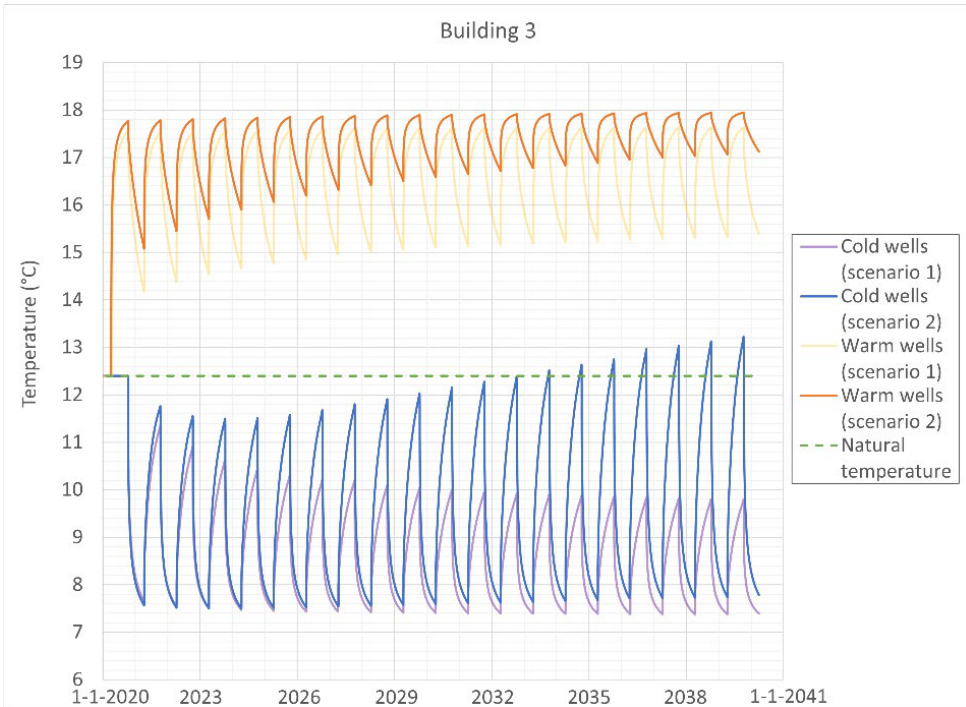
Figure 12. Simulated long-term evolution of the mean temperature at the hot and cold wells (in the deep aquifer) for Building 3 for the third scenario with a constant Δ T equal to 6 °C, compared with the first scenario.